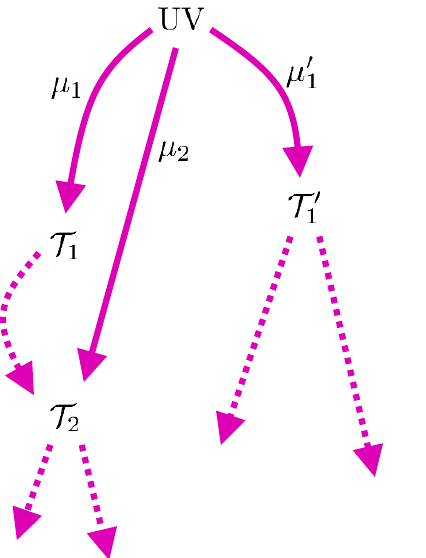
Figure 1. Depiction of the network of 4D RG (cid:13)ows generated by elements of the nilpotent cone. Starting from a UV N = 2 (cid:12)xed point, each nilpotent orbit in the (cid:13)avor symmetry algebra determines a candidate N = 1 (cid:12)xed point. Additionally, the network of connections